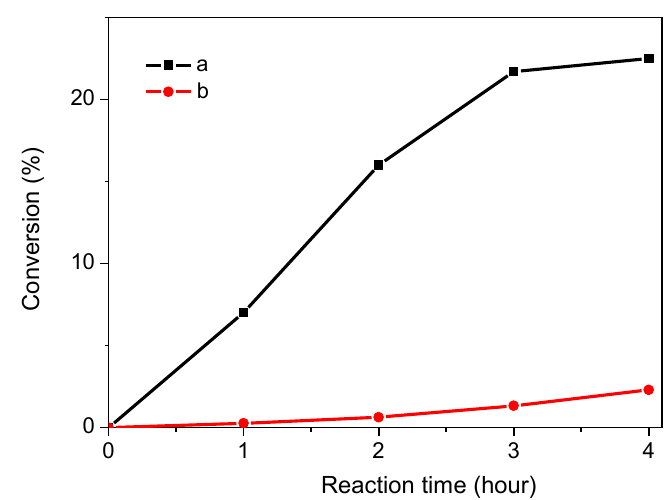
Figure 10. Reaction progress for the catalytic oxidation of (a) benzyl alcohol and (b) benzaldehyde at 100 °C of reaction temperature. The concentration of benzyl alcohol and benzaldehyde is 5 M in toluene. First, 5 mM of complex 4 was applied to the reactions. The conversion was measured by HPLC for the transformation of benzyl alcohol into benzaldehyde and for benzaldehyde into benzoic acid.